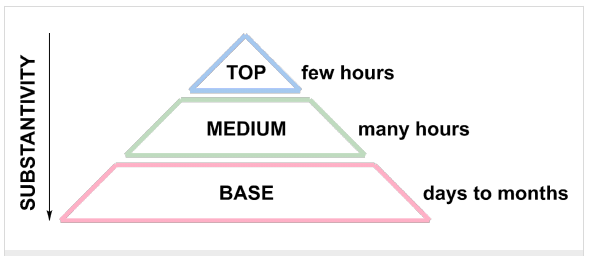
Figure 2: Classification of odorants as “top note”, “middle note” and “base note” depending on their